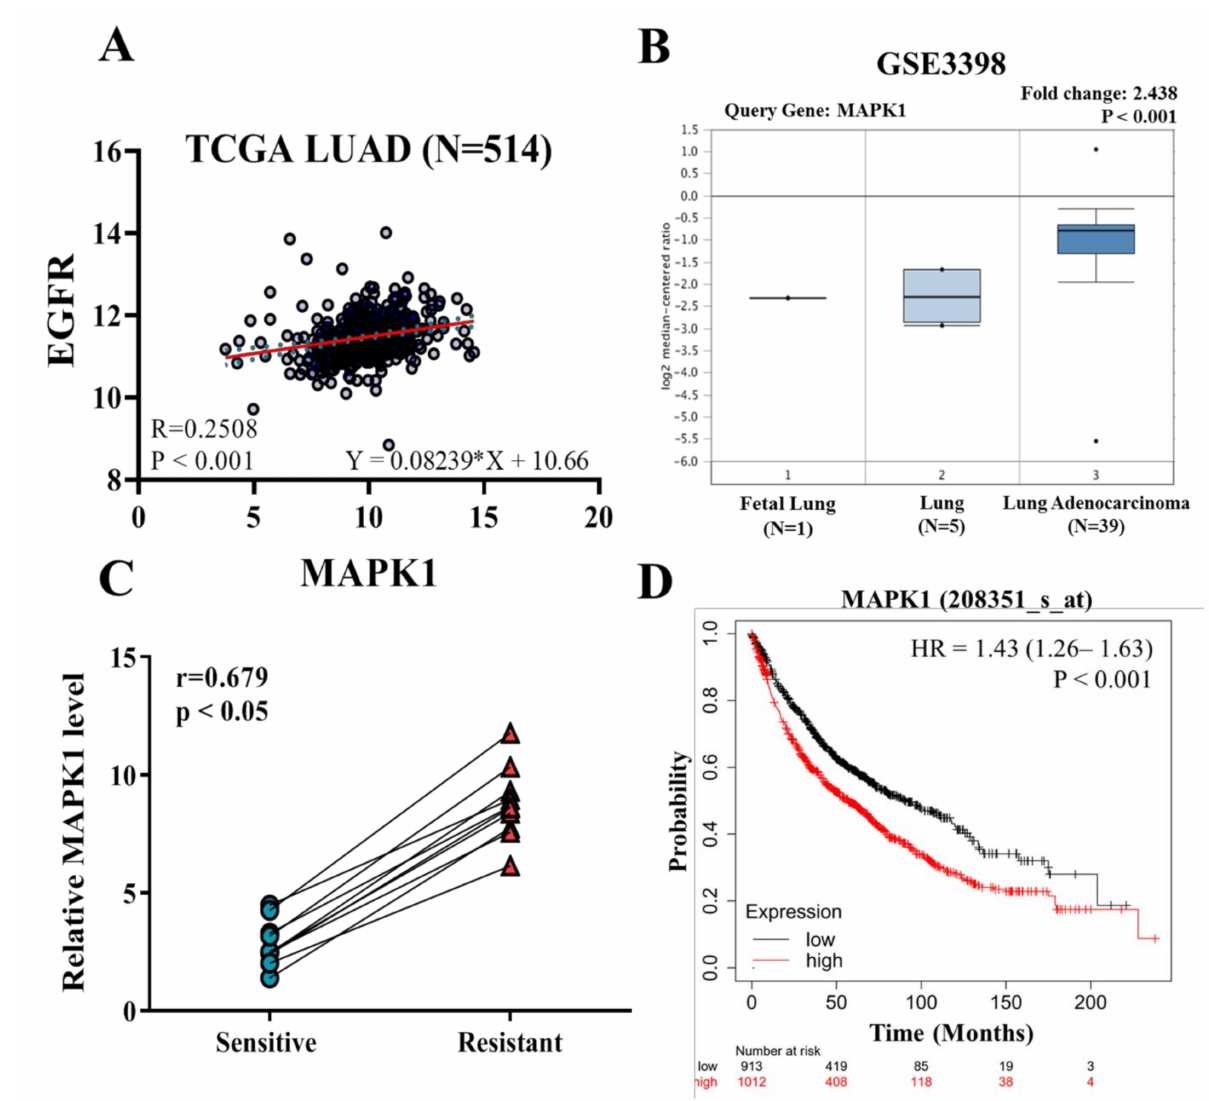
Figure 1. Elevated co-expression of EGFR and MAPK1 (also known as ERK2) is associated with poor prognosis in NSCLC patients and Osimertinib resistance. ( A ) TCGA lung adenocarcinoma database analysis (N = 514) revealed a positive correlation between EGFR and ERK (r = 0.2508, p < 0.001). ( B ) Comparative expression analysis shows a significantly higher MAPK1 mRNA in lung adenocarcinoma samples as compared to normal lung and fetal lung tissues ( p < 0.001) [16]. ( C ) Clinical samples of Osimertinib-resistant NSCLC samples contained a significantly higher MAPK1 level as compared to their sensitive counterparts (10 pairs). Pearson correlation r = 0.679, p < 0.05. ( D ) Kaplan-Meier analysis of the NSCLC cohort (N = 1925) revealed a significant correlation between an elevated MAPK1 mRNA with worse survival (log-rank p <